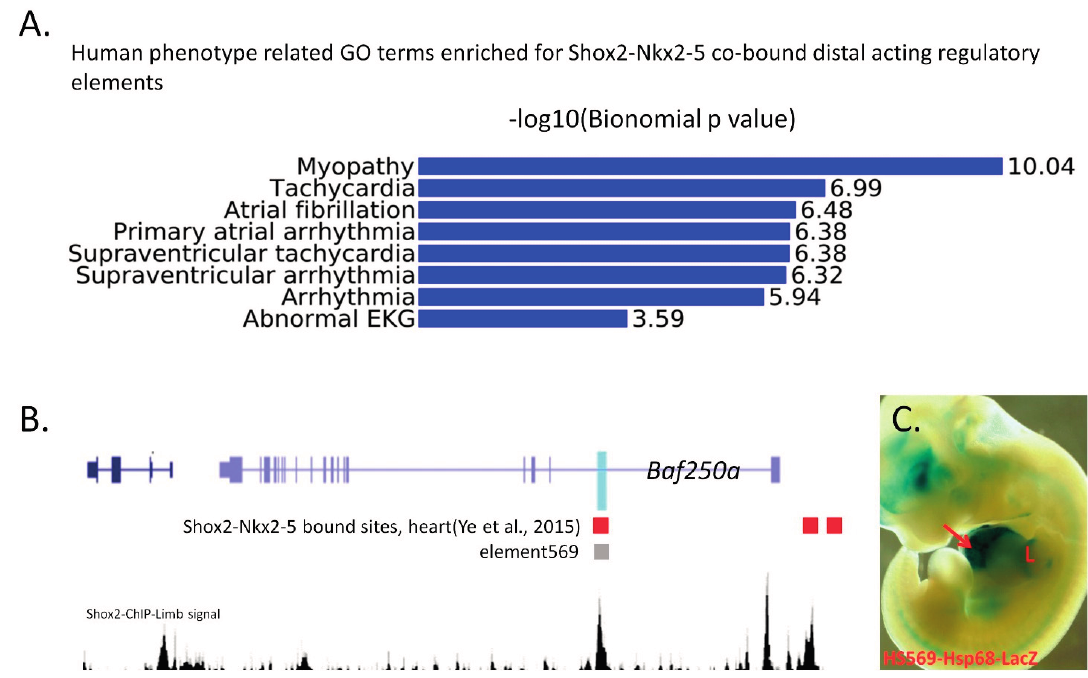
Figure 4. ( A ) Gene-ontology analysis reveals highly enriched atrial fibrillation related function in the Shox2-Nkx2-5 co-bound distal acting regulatory elements. ( B ) Signal track of Shox2-binding in the developing limb at E12.5 in relation to HS569, an enhancer of Baf250a , and Shox2-Nkx2-5 co-bound sites in the embryonic heart. ( C ) An E11.5 transgenic embryo carrying a reporter construct driven by Shox2-bound distal acting regulatory element (HS569) shows LacZ expression in the heart (arrow) and limb